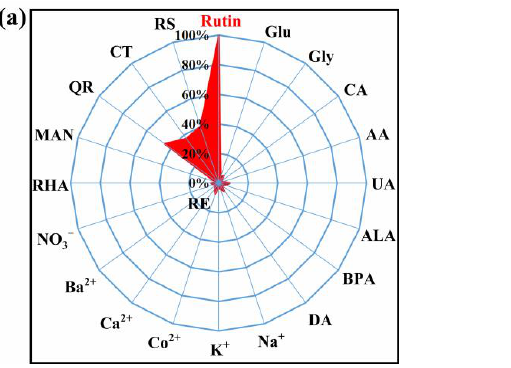
Figure 3. ( a ) The selectivity of NF/AuNPs/FLBP@pN-CPNDs/CILE to rutin over other analytes. The radar chart shows the RE of interferents on 20.0 μmol L −1 rutin determination; ( b ) oxidation peak currents of NF/AuNPs/N- CPDs@FLBP/CILE for rutin (20.0 μmol L −1 ) after storage in a 4 °C refrig- erator for 6 weeks. (Notes: RHA, rhamnose; MAN, mannose; Glu, glucose; Gly, glycine; CA, citric acid; AA, ascorbic acid; UA, uric acid; ALA, alanine; DA, dopamine; BPA, bisphenol; QR, quercetin; CT, catechol; RS, resorcinol).